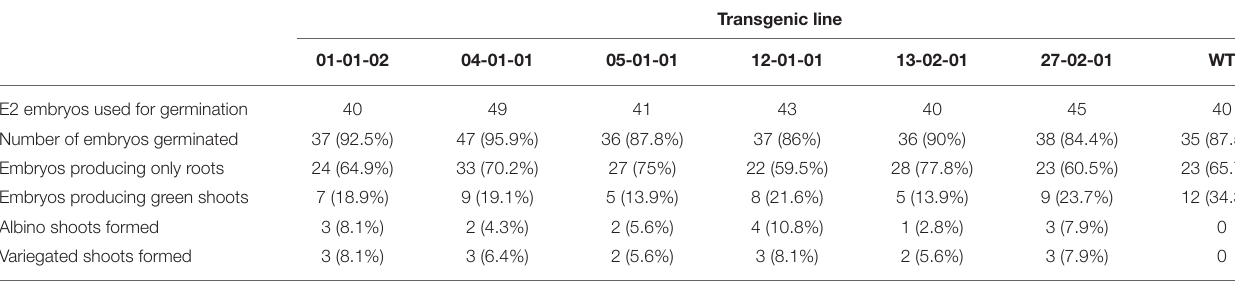
TABLE 4 | Emergence rate of mutated plants from transformed and untransformed Chandler